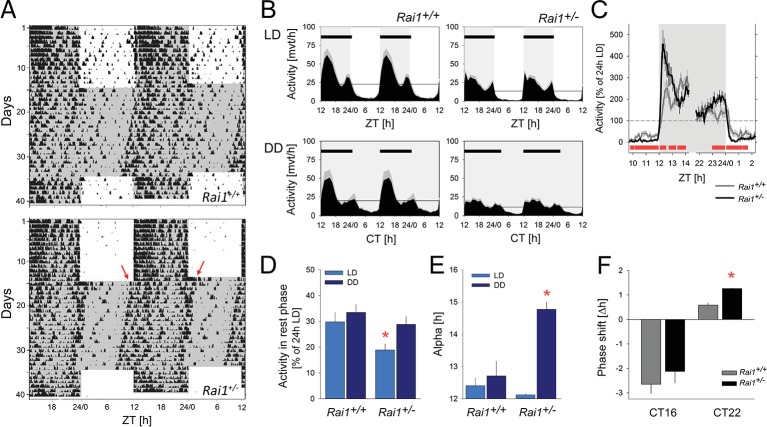
Marked suppression of locomotor activity by light in Rai1+/- mice.(A) Representative double-plotted actograms of one wild-type Rai1+/+ (top) and one Rai1+/- mouse (bottom panel), under 14 days of LD12:12 and 20 days of constant darkness (DD). Grey areas mark darkness. Note that in Rai1+/- mice activity is restricted to the dark periods under LD12:12 and that after the transition into DD its active period (alpha) expands with an earlier onset and a delayed offset (red arrows) of activity. (B) Average profiles of hourly activity values (black area with SEM in grey) under LD12:12 (top) and DD (bottom panels) for Rai1+/+ (left; n = 11) and Rai1+/- (right panels; n = 12). Light-grey areas denote periods of darkness. Horizontal black bars indicate mean active periods (alpha or α; see also Panel E). Note the alpha expansion under DD and overall lower activity in Rai1+/- mice. Horizontal lines indicate average 24 hr activity levels for each genotype under each condition. The LD12:12 average activity levels were used in Panels C and D to correct for genotype differences in overall activity levels. (C) The suppression of activity by light in Rai1+/- mice under LD12:12 was abrupt and the relative increase in activity immediately following dark onset and immediately preceding light onset were ~2 fold larger than in wild-type mice. Values were expressed as % of each animal’s 24 hr average activity under LD12:12 conditions (=100% dashed horizontal line). (D) Even after correcting for individual differences in overall activity (set to 100% as in C), activity in the 12 hr light periods remains lower in Rai1+/- mice compared to wild-type littermates (light blue bars; p<0.05, t-test) and also compared to their own activity during the rest phase under DD (rho or ρ; dark blue bars; *p<0.01, paired t-test). (E) Comparison of alpha under LD12:12 and DD conditions. Alpha expansion was observed only in Rai1+/- mice (*p<0.001, paired t-test). (F) A light pulse at CT22 elicited a ~ 1 hr larger phase advance in Rai1+/- mice compared to wild-type littermates (*p<0.005, t-test), while a light pulse administered at CT16 resulted in the expected phase delay. Note that this experiment was performed in a separate cohort of mice (Rai1+/- n = 4; Rai1+/+ n = 5). Error bars represent SEMs.DOI:
http://dx.doi.org/10.7554/eLife.23292.00210.7554/eLife.23292.003Figure 1—source data 1.Excel file with data sheets corresponding to each figure panel containing the numerical values on which Figure 1 and Figure 1—figure supplement 1 are based.For Figure 1 panels D-F and Figure 1—figure supplement 1 individual data are provided as well.